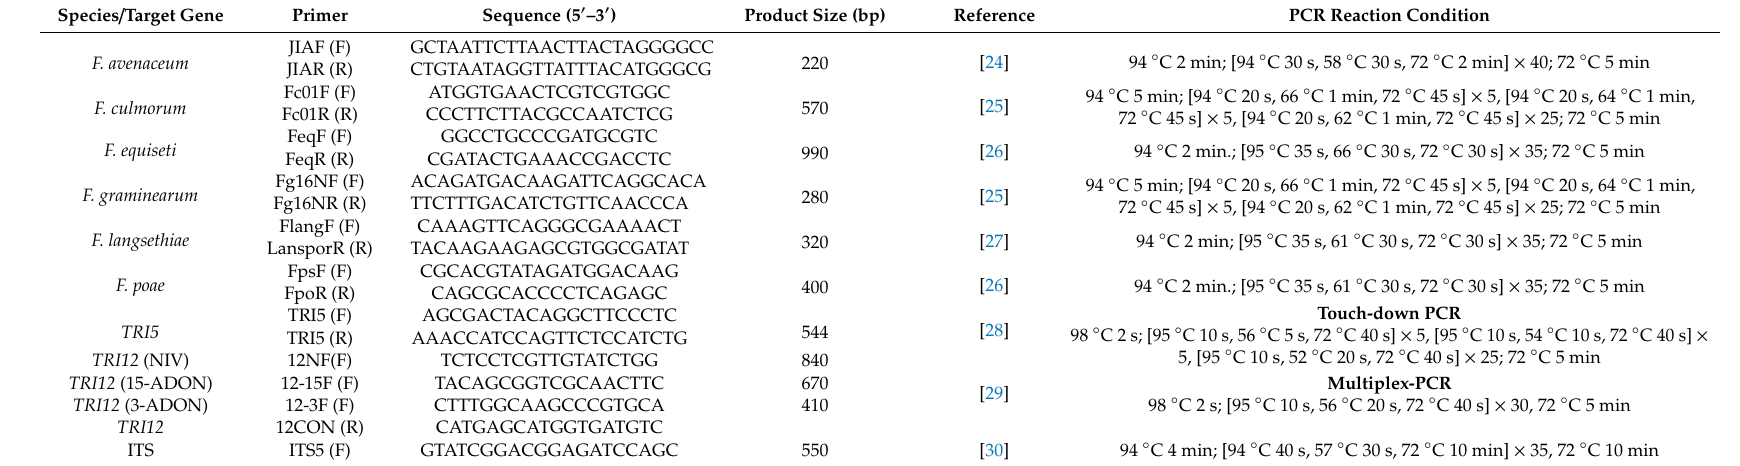
Table 2. Primer sequences and PCR conditions for species identification based on ITS sequences and the determination of trichothecene genotypes. Species / Target